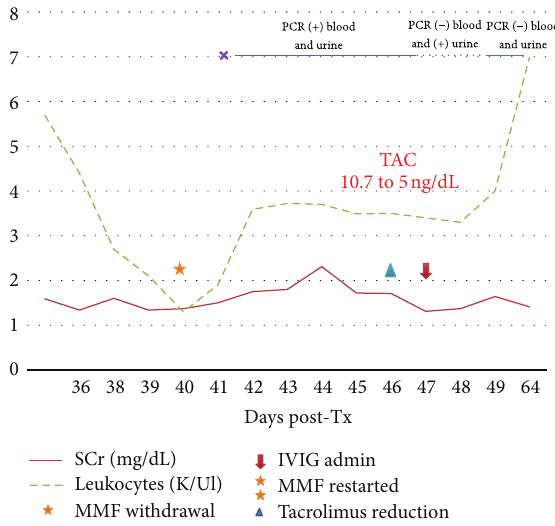
Figure 3: Case 2: correlation of SCr, leukocytes, and treatment